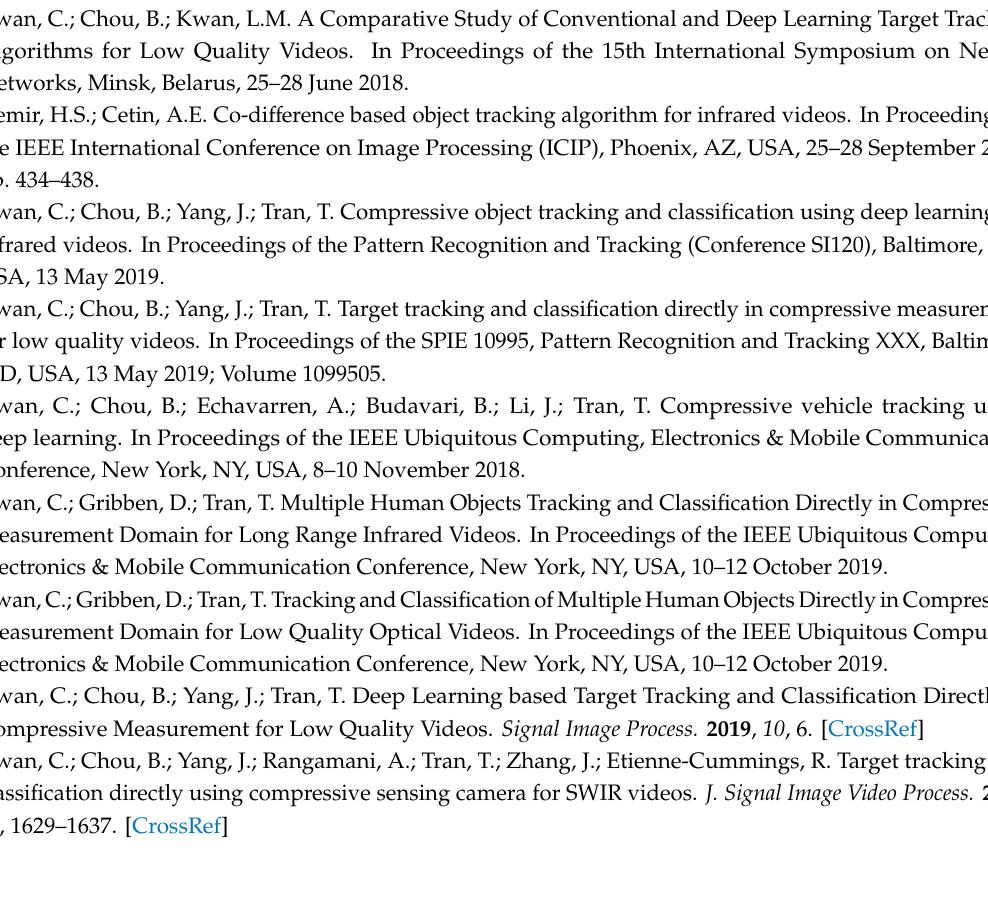
Figure A10. Three frames from 5000 m for Approach 1 and 3a. ( a ) Approach 1; ( b ) Approach 3a.